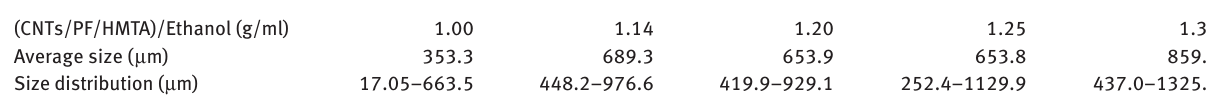
Table 2 Effects of dispersed phase ratio on the average size and size distribution of spheres. (CNTs/PF/HMTA)/Ethanol (g/ml)